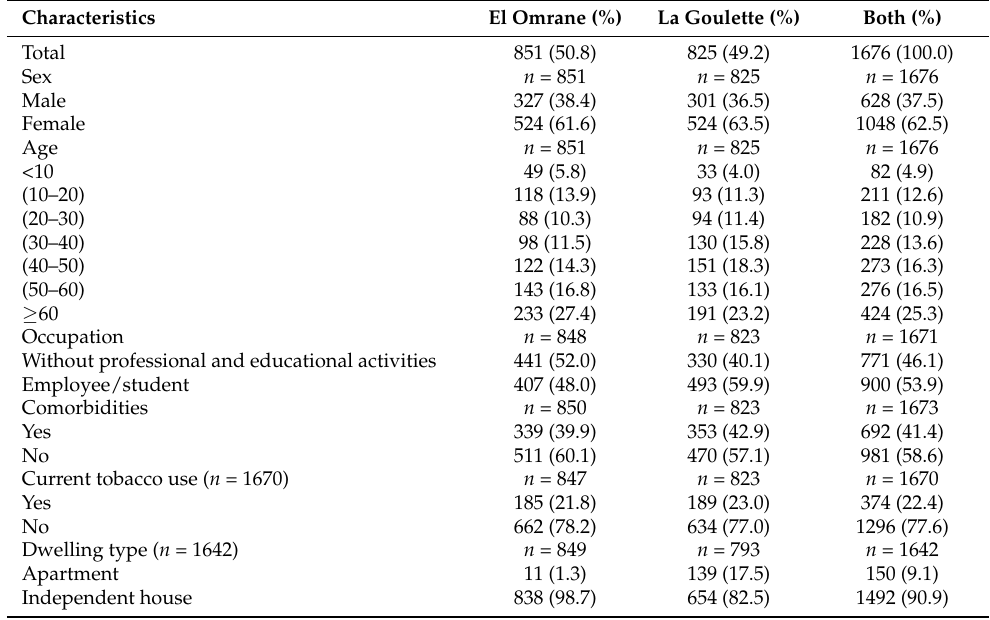
Table 1. Sociodemographic characteristics and lifestyle habits of the study population, Tunis,